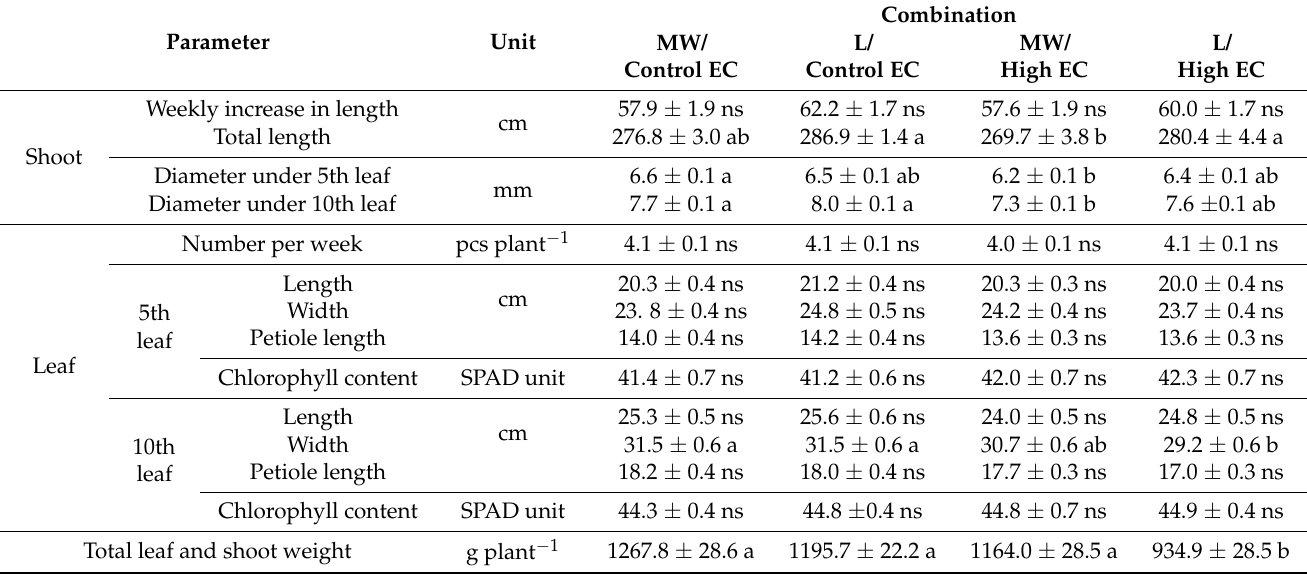
(Table 1). The high EC of the nutrient solution reduced the total leaf and shoot weight of plants growing in lignite by nearly 20% compared to the lower EC of the nutrient solution and mineral wool. There were no significant differences in the SPAD index of cucumber leaves depending on the substrate and EC of the nutrient solution applied (Table 1). Table 1. Chosen morphological parameters of cucumber plants and chlorophyll content (SPAD) in relation to medium and nutrient solution EC (average from two